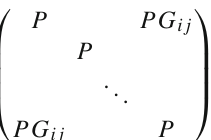
threshold strategy to the similarity matrix. In addition, situ- ations with outliers and different choices of K strategies are